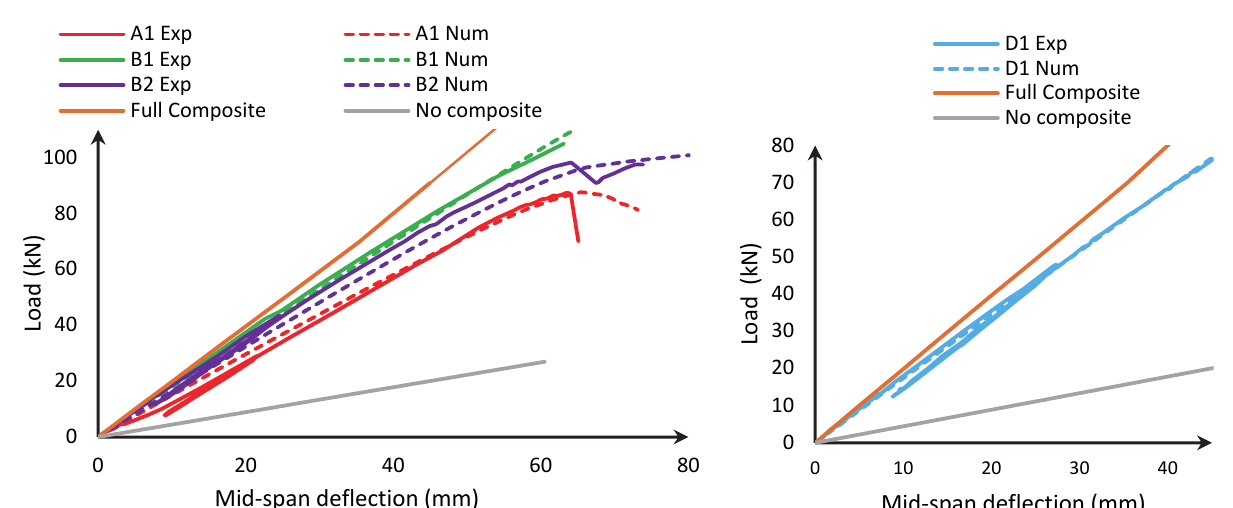
Figure 10: The load-mid-span deflection curves of the modelled TCC beams with rectangular notch connections R150 (left) and R300 (right) compared with the experimental